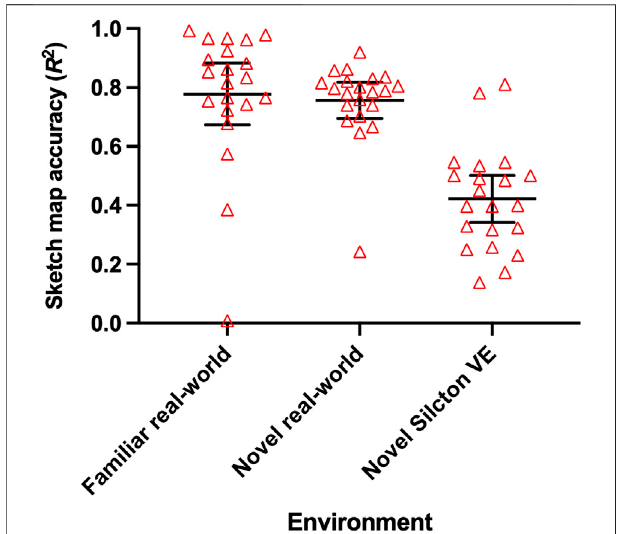
FIGURE 6 | Sketch map accuracy (R 2 ) across the three conditions in Experiment 2. Centre lines show means and the error bars show 95% con fi dence intervals. Triangles indicate individual scores, and the degree of horizonal scatter of the scores re fl ects the number of scores at that